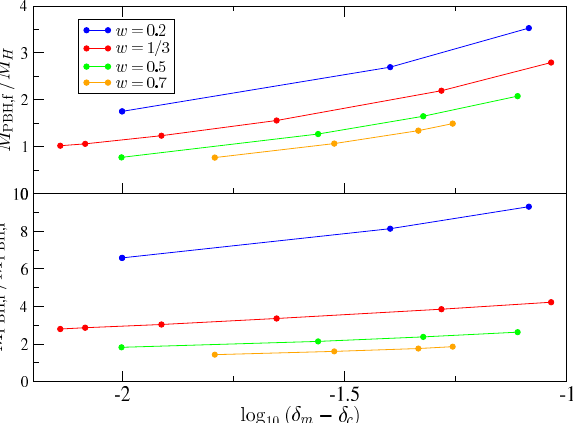
Figure 20. ( Top-panel) : Values of the final PBH mass in terms of M H for some values of w as a function of δ m − δ c . ( Bottom-panel ): Accretion effect on the final PBH mass for some values of w as a function of δ m − δ c . In both cases, the profile of Equation (83) was used with q = 1 and λ =